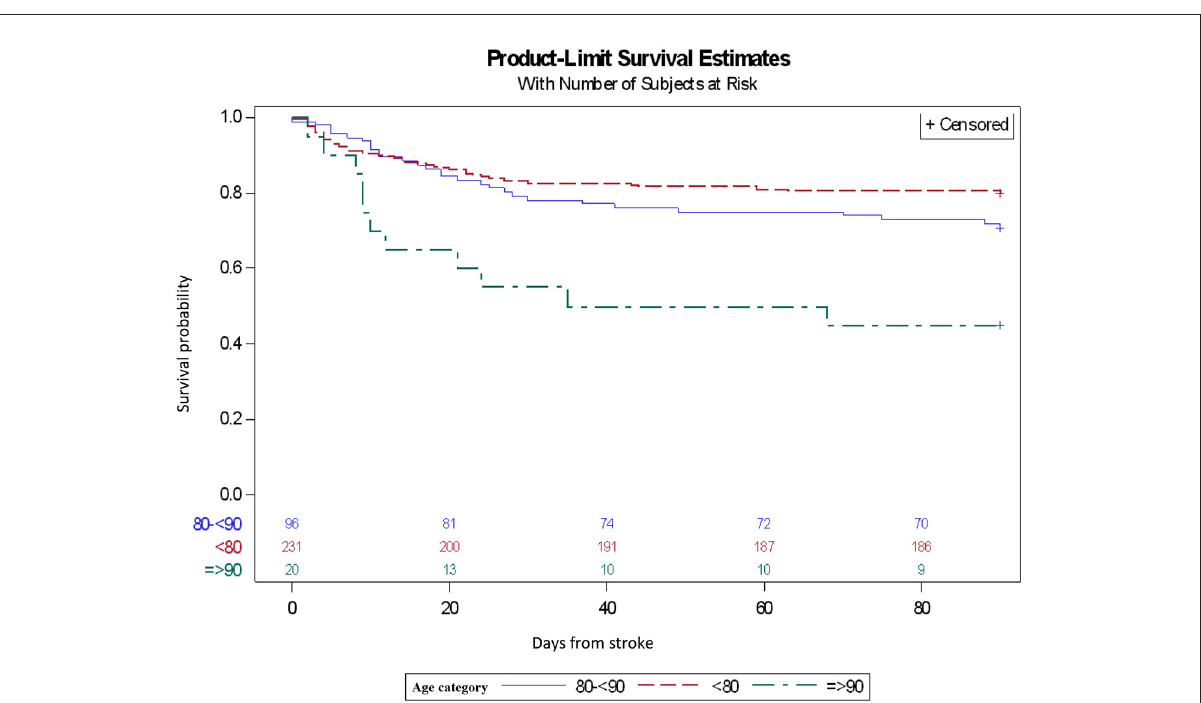
FIGURE1 Kaplan-Meier plot of mortality rates at 90 days by age